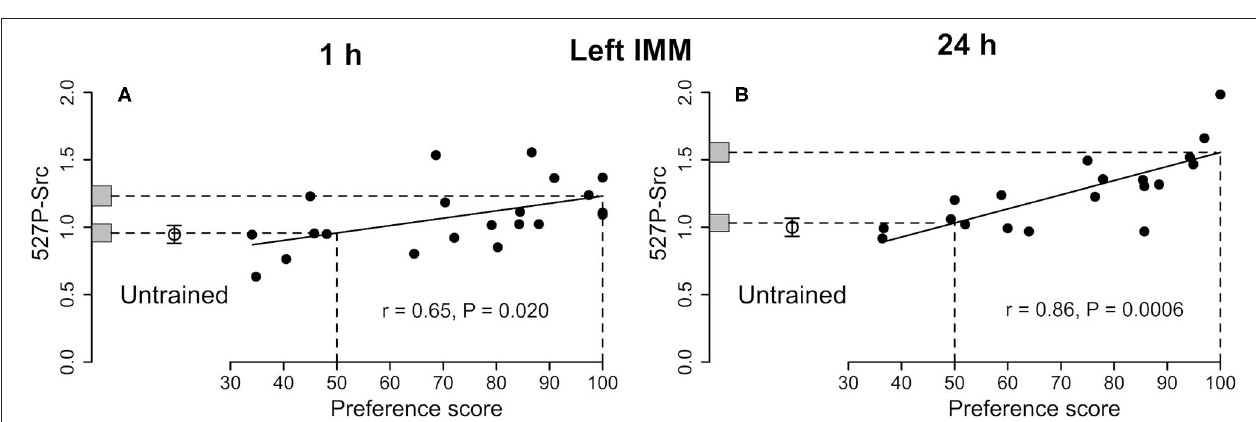
FIGURE 2 | Left IMM. Standardized relative amount of 416P-Src plotted against preference score 1h (A) and 24h (B) after the end of training. Conventions otherwise as for Figure 1A , the correlation is significant; the mean value for untrained chicks is not significantly different from either intercept on the y -axis. (B) Correlation not significant.